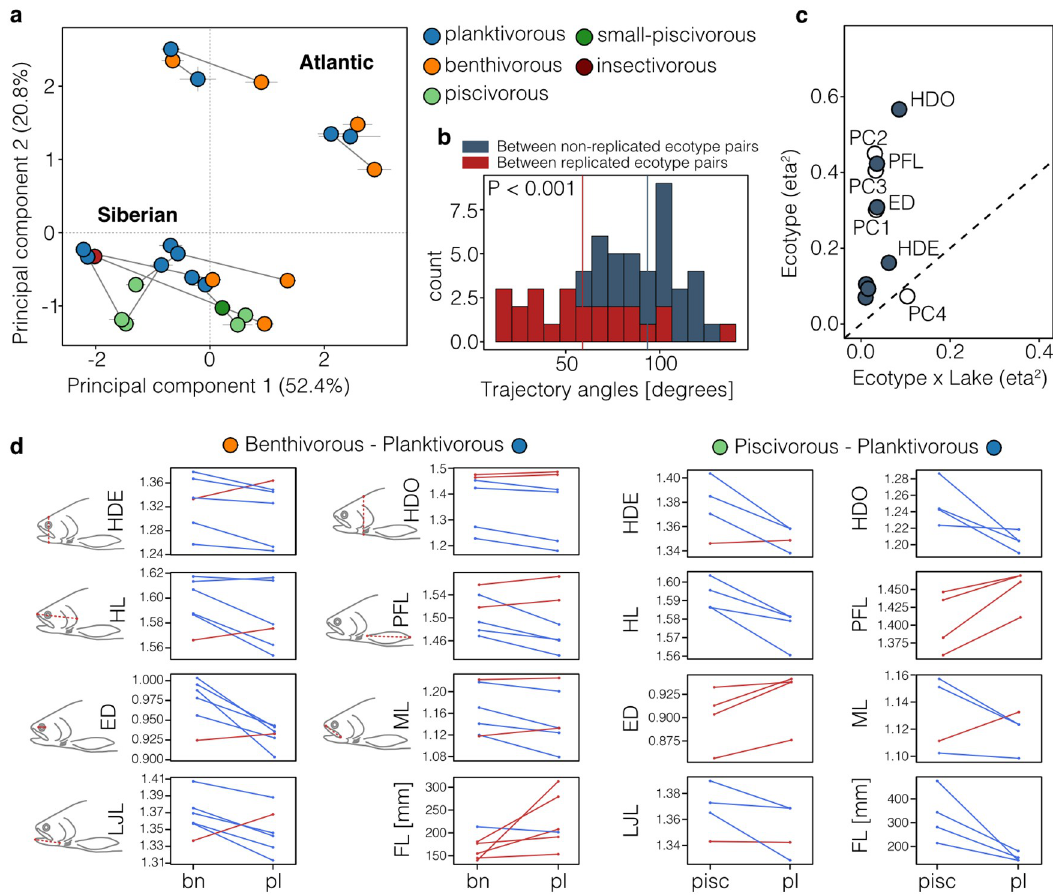
Fig 2. Continuum of phenotypic parallelism. ( A ) Principal components plot based on all seven linear traits showing the centroid ± s.e. for each ecotype (N = 1,329 individuals), with centroids of sympatric ecotypes connected by trajectories. Points are coloured by ecotype: bn–benthivorous, pl–planktivorous, pisc–piscivorous, pisc-s–small-piscivorous, insct–insectivorous. ( B ) Phenotypic trajectory angles between replicated ecotype pairs and between non-replicated ecotype pairs, with mean angles highlighted by dashed lines. Angles between replicated ecotype pairs were significantly smaller compared to non-replicated ecotype pairs (Wilcoxon test: P < 0.001) ( C ) Effect sizes (partial η 2 ) of the ecotype and ‘ecotype x lake’ interaction terms for all seven linear traits (dark dots) and PC1 to PC4 (white dots). Traits above the dashed diagonal line show stronger parallel than non-parallel divergence across ecotype pairs. ( D ) Mean size-adjusted trait-values and mean fork length (in mm) are plotted for each benthivorous-planktivorous and piscivorous-planktivorous ecotype pair, with means for sympatric pair being connected by a line. These reaction norms are colour coded blue and red highlighting the decrease or increase of trait values, respectively, between benthivorous (bn) or piscivorous (pisc) and planktivorous (pl) ecotypes. The measured traits are illustrated next to each plot for the benthivorous-planktivorous pairs. See text, panel 1C and S1 Fig for details on statistical